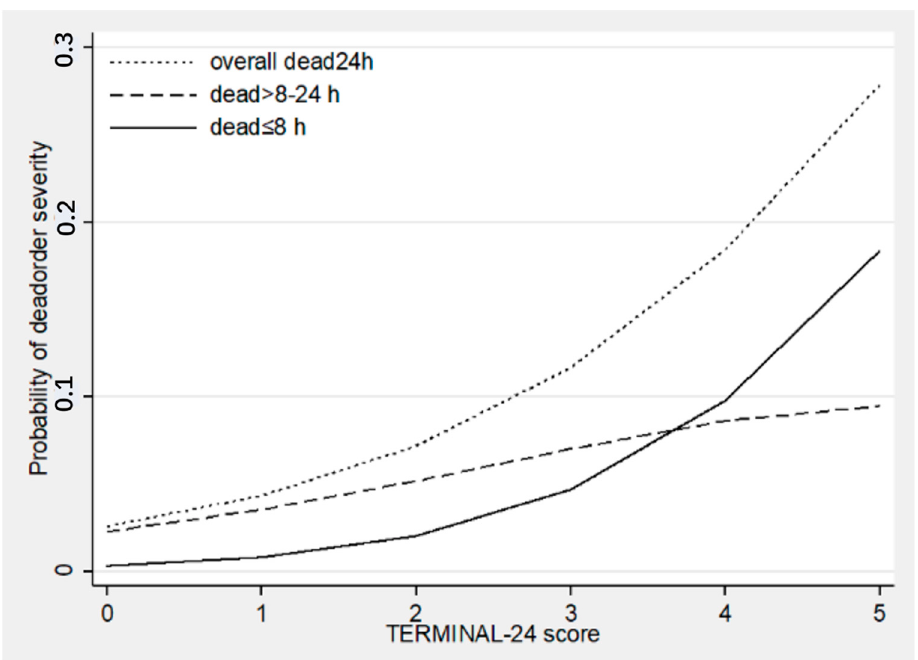
Figure 3. The discrimination of the probability of death based on TERMINAL-24 score. The dotted line represents the probability of overall death in 24 h, the dashed line represents the probability of death between 8 and 24 h, and the solid line represents the probability of death in under 8 h.